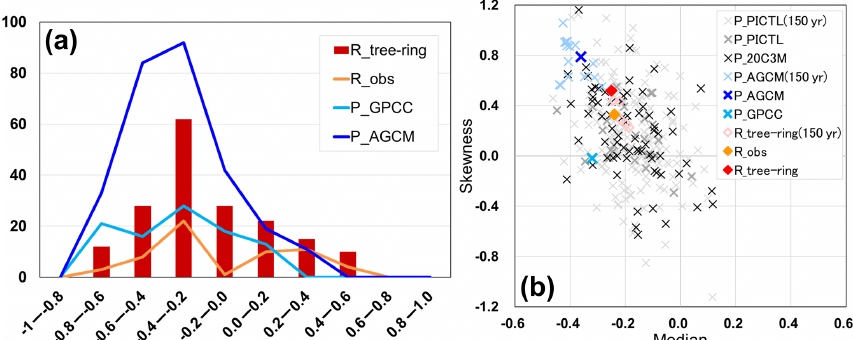
Figure 3. (a) Histogram of 15-year running correlations from the tree-ring-reconstructed annual R (red bars), observed autumn R (orange line), observed summer P (light blue line), and AGCM-simulated summer P (blue line). (b) Scatter diagram between median and skewness of each of the 15-year correlations. Simulated P in the CMIP3 models’ simulations (20C3M and PICTL) and subsets of 150-year record for the reconstructed R (five samples), AGCM-simulated P (15 samples), and PICTL-simulated P (over 100 samples) are also plotted.